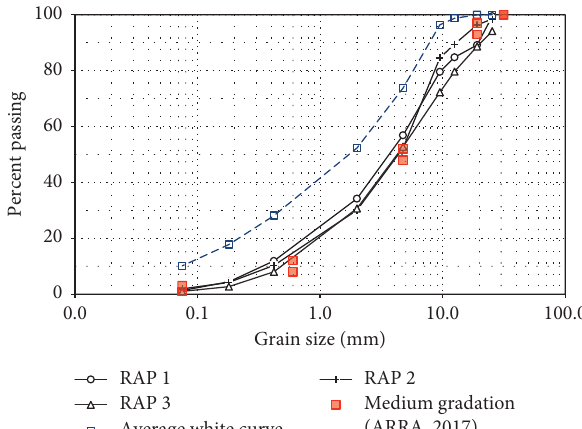
Figure 1: Grain-size distribution of the RAP